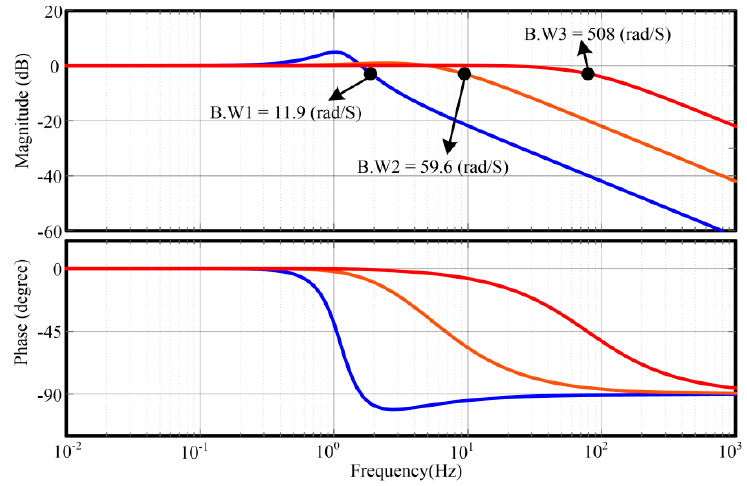
Figure 9. Closed-loop frequency response of SRF-PLL. The Bode plot of parallel compensated weak grid impedance in (31) with ( C g 2 = 0.0032 F and 0.0062 constituting Z gp 1 and Z gp 2 ), and the DFIG system impedance in (30) is shown in Figure 10. Energies 2020 , 13 , 1039